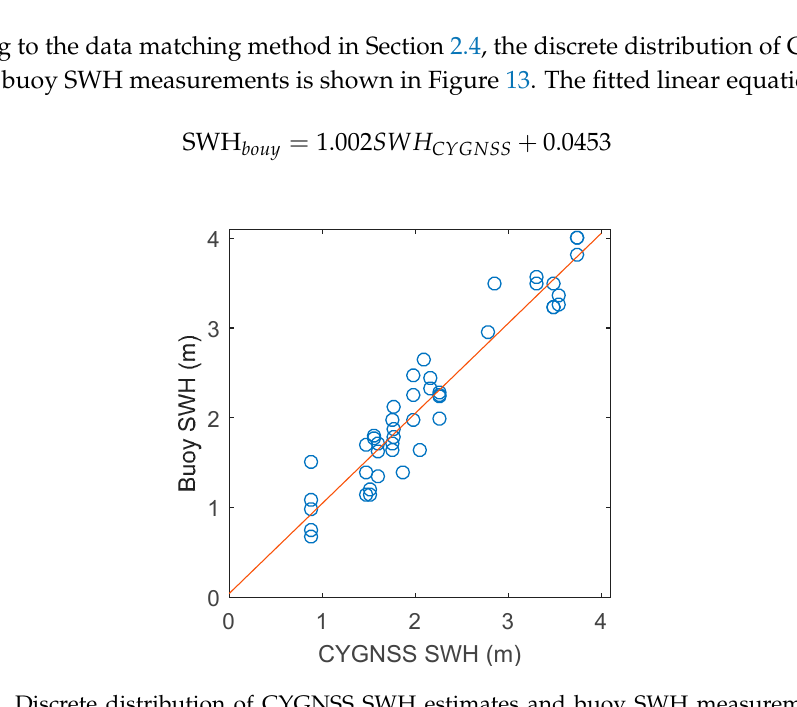
Table 3. Accuracy analysis of CYGNSS SWH estimates versus buoy SWH.